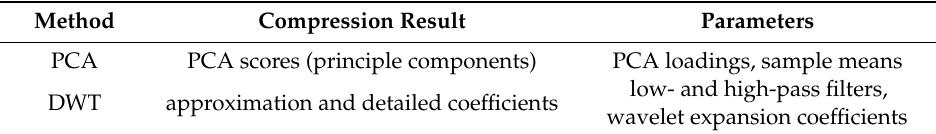
Table 1. Overview of the data compression techniques and main parameters.